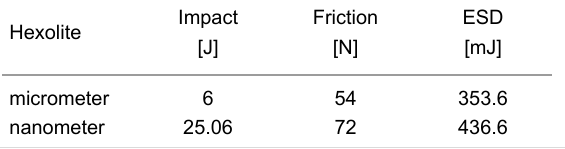
Table 2: Comparison of the sensitivity levels of micrometer-sized hexolite with those of a nanometer-sized hexolite (n-hexolite) [3].